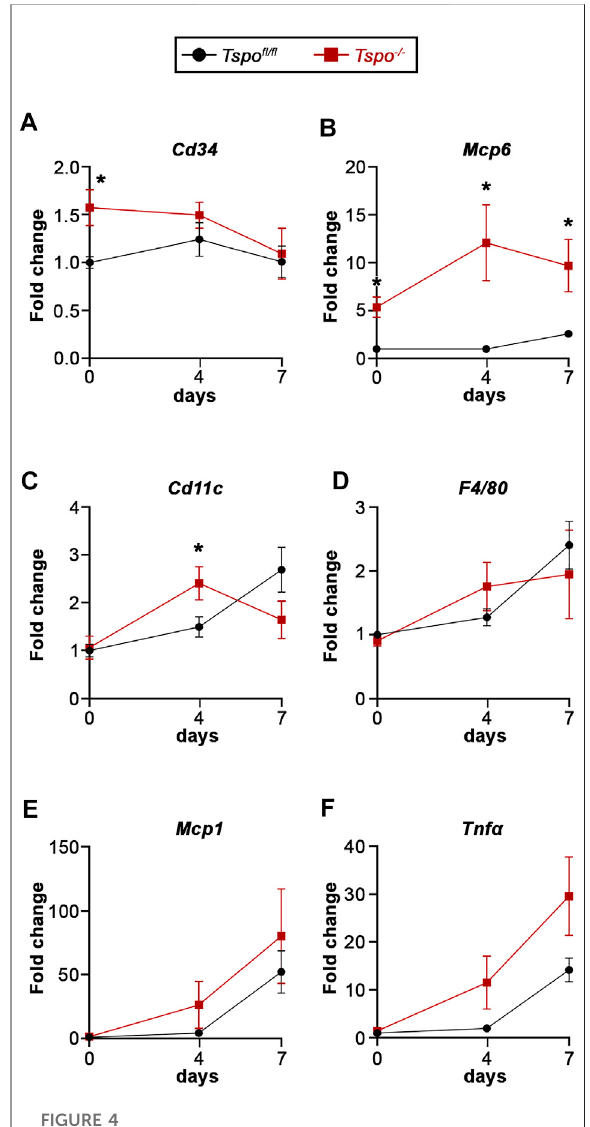
( p = 0.0638), it did not reach statistical signi fi cance. For all gene expression changes, n = 5-7 per group; signi fi cance indicated as * p <